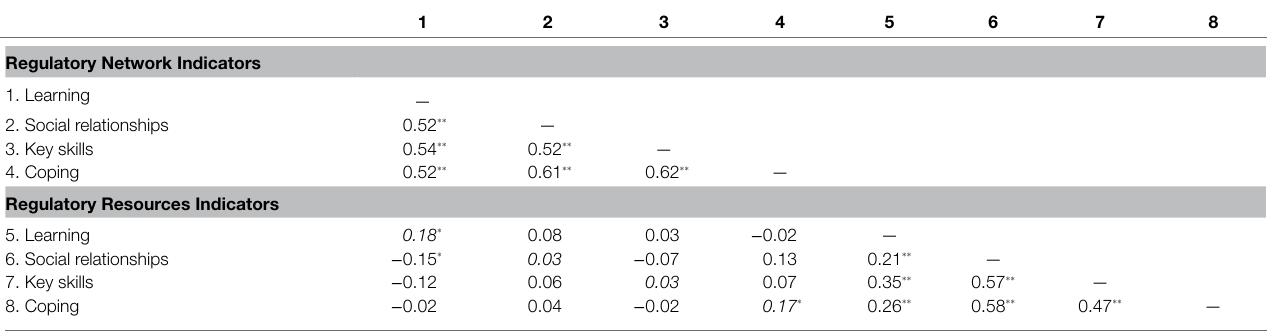
TABLE 2 | Bivariate